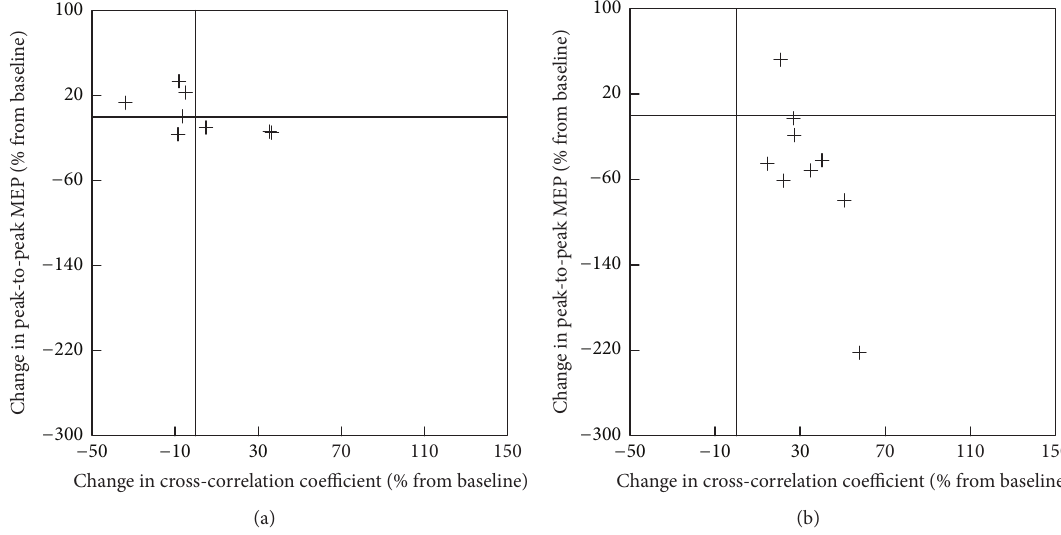
Figure7:Scatterplotsofthechangeincorticomotorexcitabilityofthenonlesionedhemisphereandthechangeincross-correlationcoefficient of reach-to-grasp for the small object. (a) Sham TMS condition. (b) Real TMS